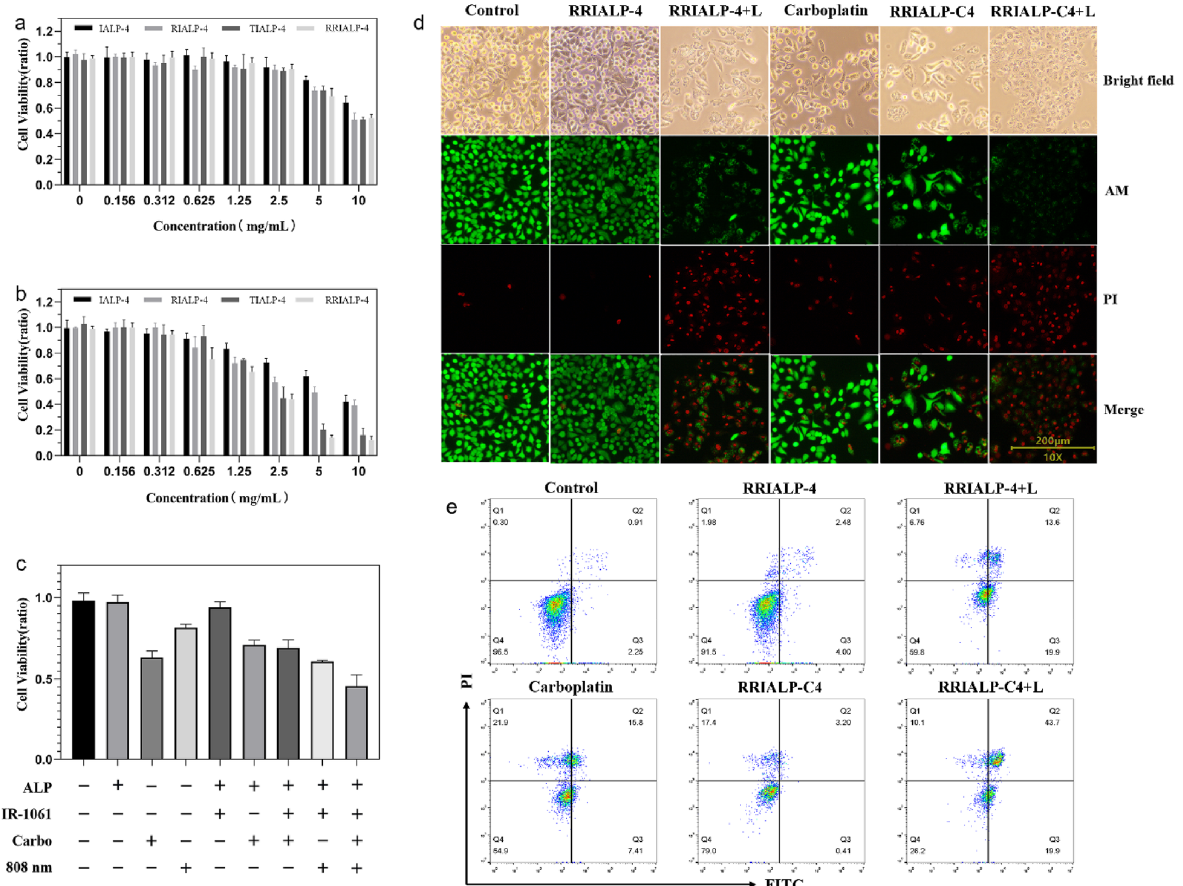
Fig. 4 In vitro photothermal therapy and synergistic treatment for A549 cells. a Cytotoxicity of different phospholipid concentrations of ALPs in A549 cells after treatment for 24 h. b Cytotoxicity of A549 cells treated with different phospholipid concentrations of ALPs for 30 min and irradiated with 808 nm laser at 0.3 W/cm 2 for 6 min. c Cell viability of A549 cells treated with liposomes at different conditions (Liposomes: 1 mg/mL; Carbo: 6.7 µM). d Fluorescent staining of dead/living cells treated with different conditions (L represented irradiation with 808 nm laser at 0.3 W/cm 2 ). Green channel: viable cells. Red channel: dead cells. e Flow cytometry of apoptosis cells treated with different conditions. Q1, Q2, Q3, and Q4 represent necrotic, late apoptotic, early apoptotic, and viable cells, respectively. (Liposomes: 1 mg/mL; Carbo: 6.7